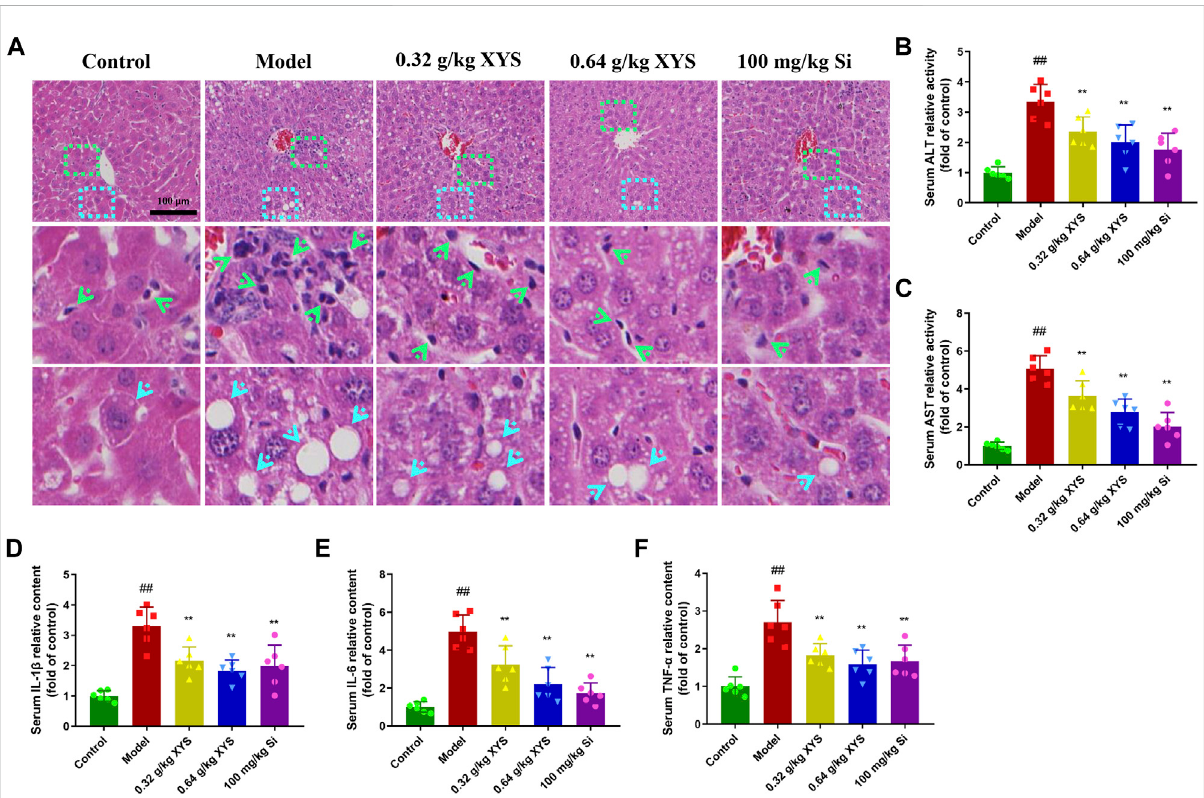
FIGURE 2 Histopathology of liver and biochemical indicators in serum with the administration of XYS and silybin. Mice were treated with XYS (0.32 or 0.64 g/kg) or silybin (100 mg/kg) via gavage for three consecutive days and sacri fi ced on the fourth day. (A) The histopathology of the mouse liver 24 hafterthelastadministration,andliversectionswerestainedwithhaematoxylinandeosin. (B) ThelevelofALTinmouseserumineachgroup,and each bar represents themean level of ALT in serum ±SD. (C) The level of AST in mouse serum in each group, and each bar represents the mean level of ASTinserum ±SD. (D) The content of IL-1 β inmouse serum ineach group, and each barrepresents themean content ofIL-1 β inserum ±SD. (E) The content of IL-6 in mouse serum in each group, and each bar represents the mean content of IL-6 in serum ±SD. (F) The content of TNF- α in mouse serum in each group, and each bar represents the mean content of TNF- α in serum ±SD. # p < 0.05 vs. Control group, and ## p < 0.01 vs. Control group; p p < 0.05 vs. Model group and pp p < 0.01 vs. Model